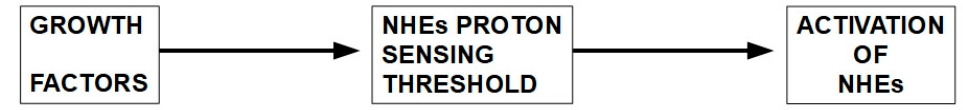
Figure 2. Mechanism of pH threshold modification of NHE1.